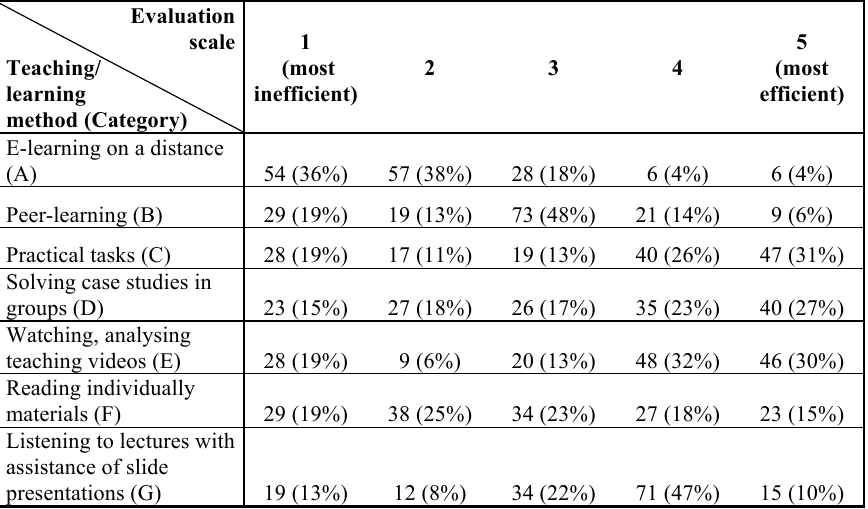
Table 1. Teaching methods evaluation (CLUSTER